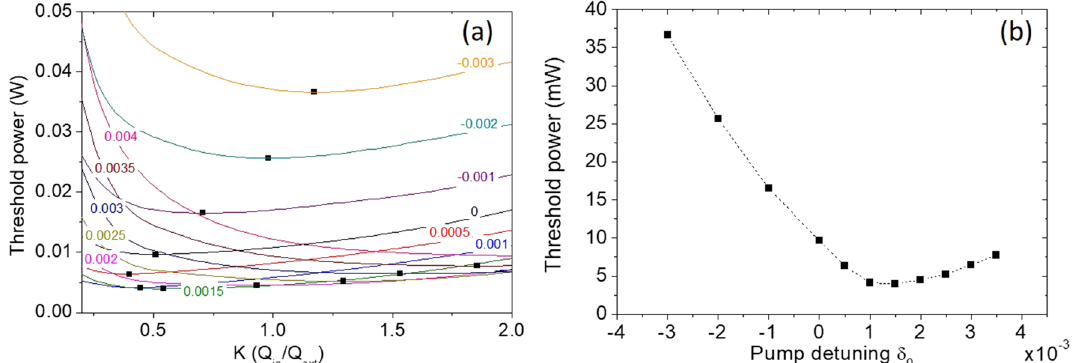
Figure 2. ( a ) Threshold power versus coupling for the pump detuning δ 0 = − 0.003 to + 0.004. Each trace is obtained by solving the LLE individually. ( b ) Minimal threshold power versus the pump detuning, corresponding to the black dots in ( a